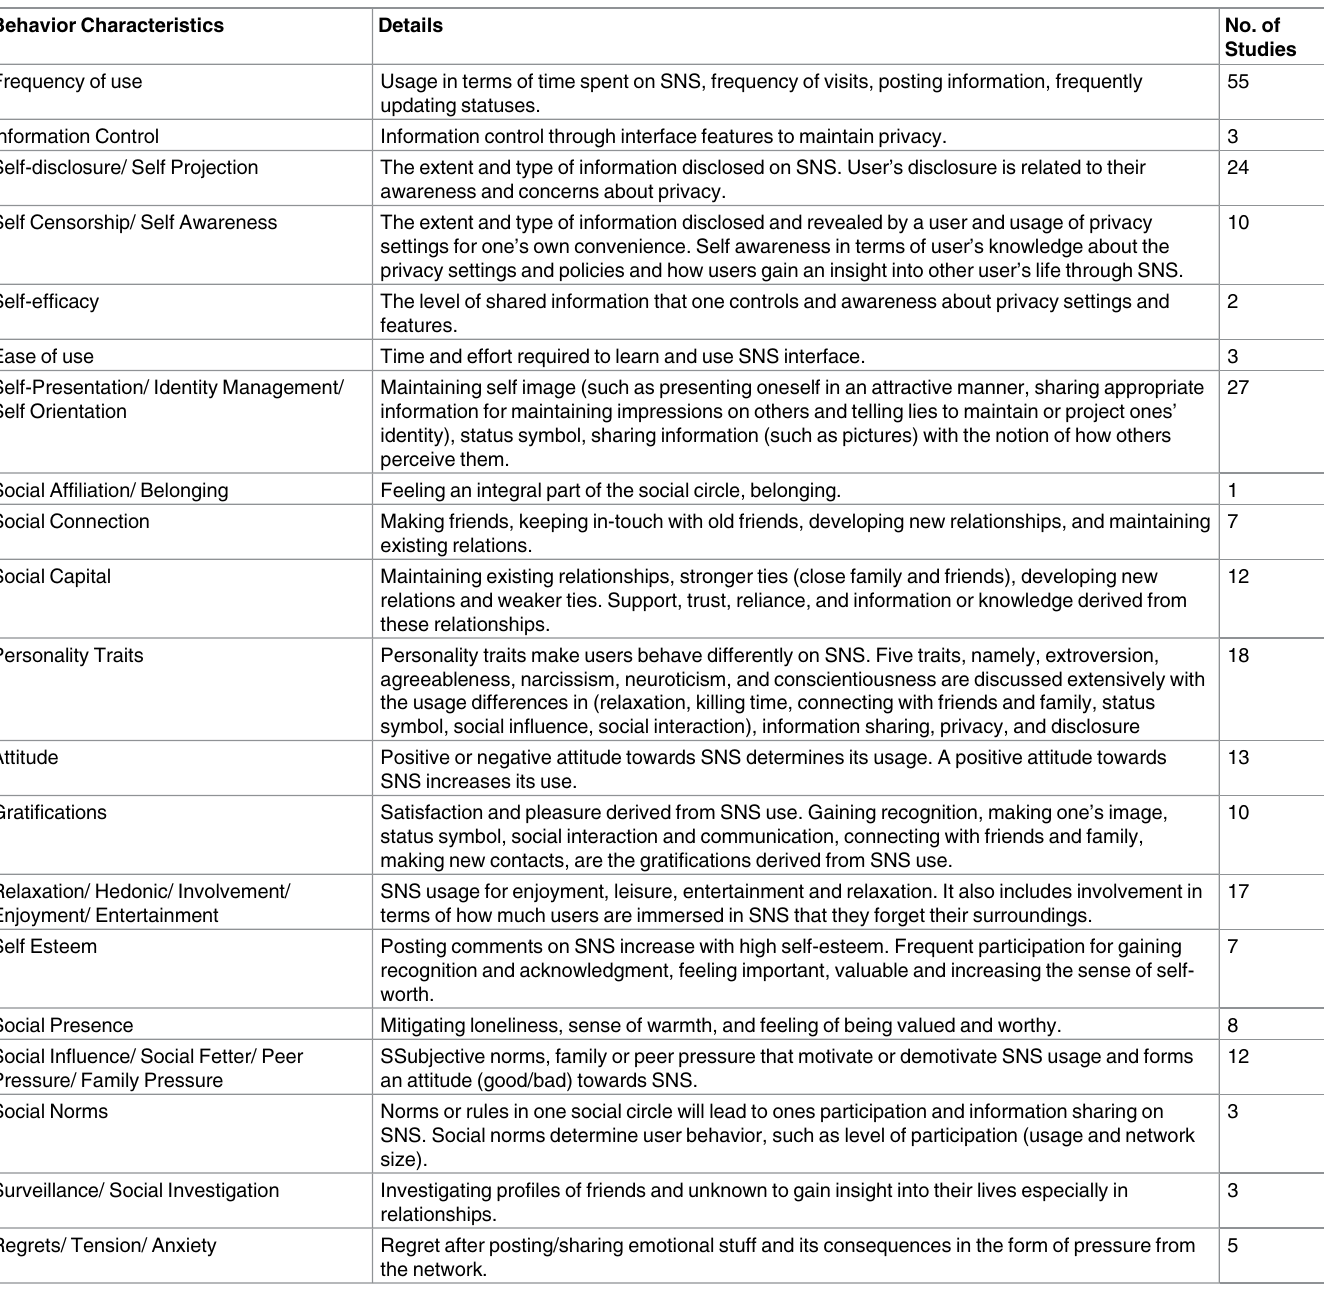
Table 9. SNS user behavior characteristics identified